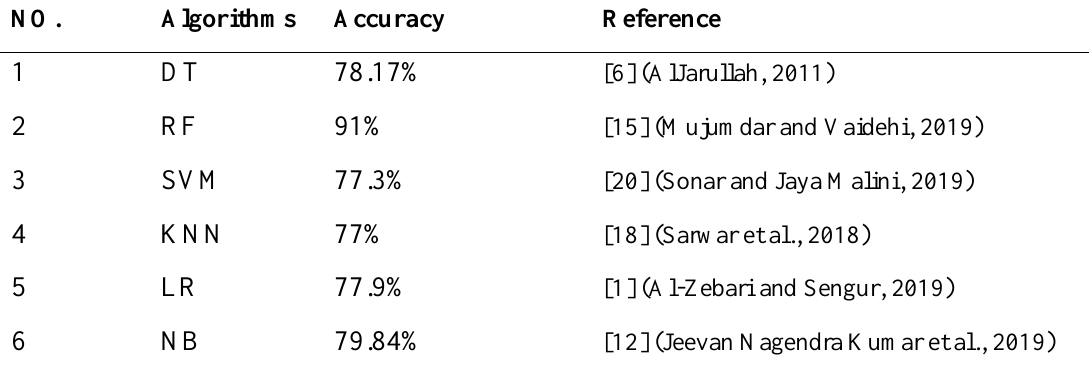
Table 9. The Classification accuracy in the proposed